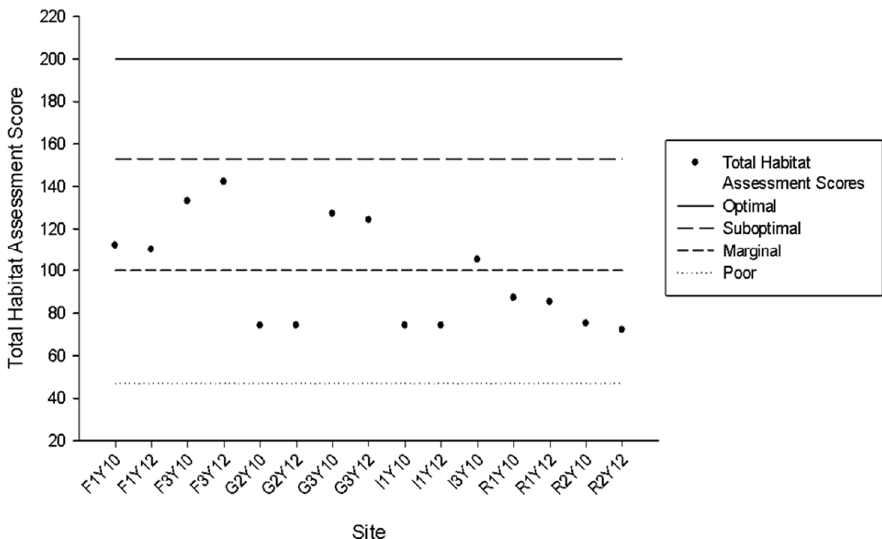
Figure 2. Total habitat assessment scores from the USEPA rapid habitat bioassessment at varying Land Use Land Cover sampling treatment stations in the Neponset River watershed for August 2010 (Y10) and August 2012 (Y12). Habitat quality is ranked from “optimal” (highest) to “poor” (lowest) (F = Forested (F1 and F3); G = Golf (G2 and G3), I = Industrial (I1 and I3, and R = Residential (R1 and R3)).